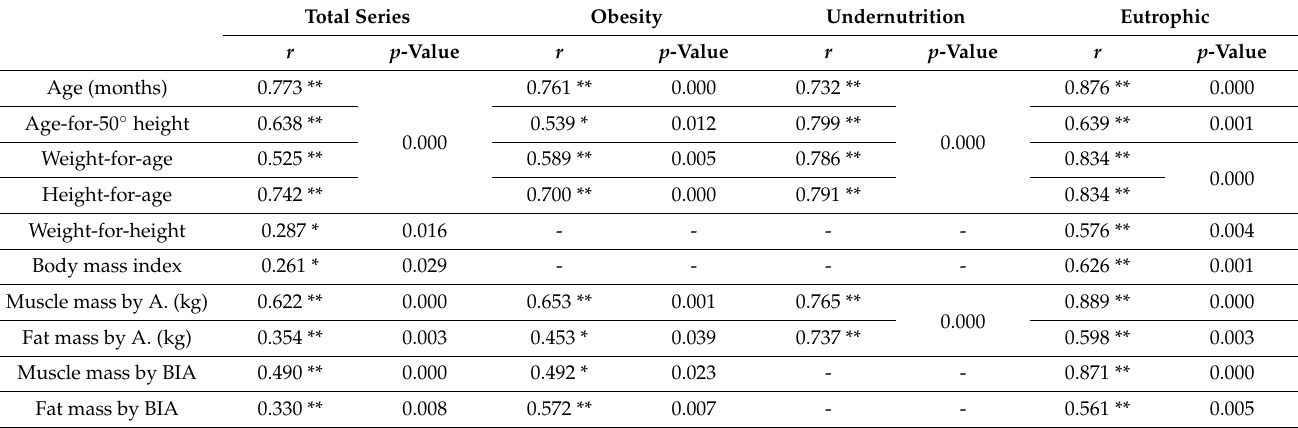
Table 8 and Tables S1–S5 (Supplementary Materials) show the linear and multilinear regression analysis between serum and dietary levels of Ca and Mg and Ca/Mg ratios in the whole series, by the nutritional group and age group (children and